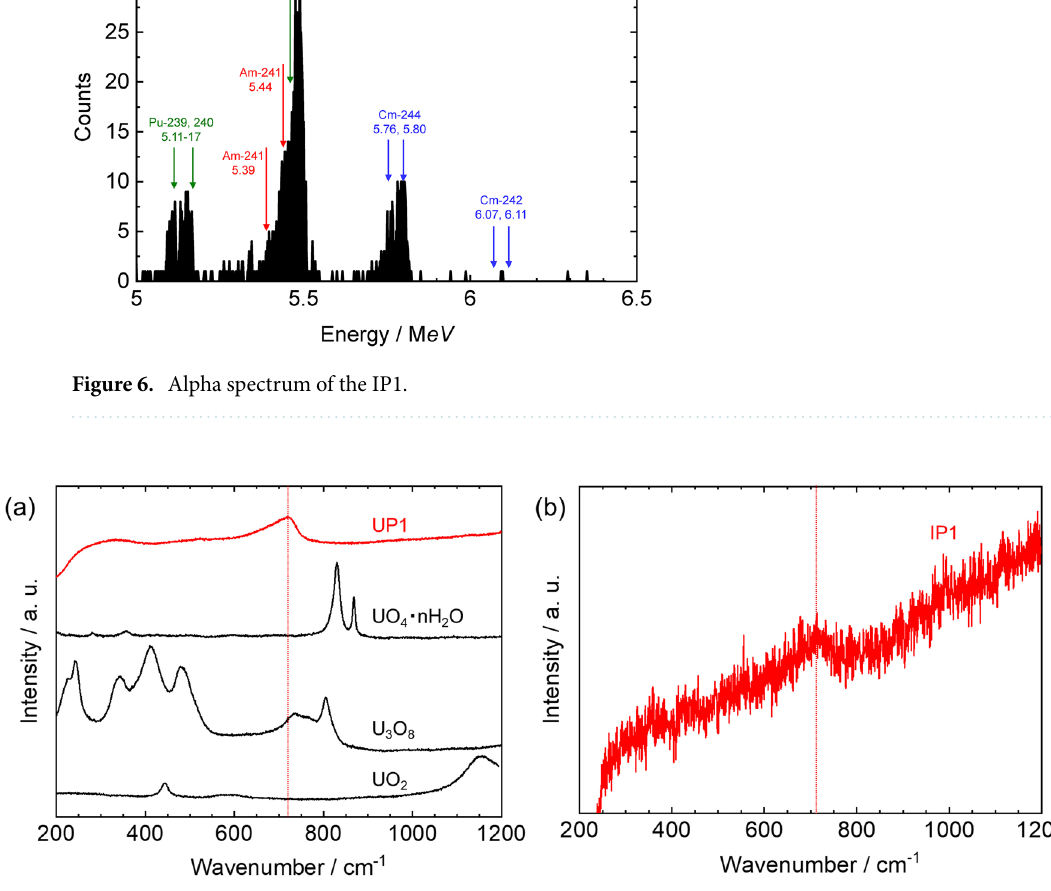
Figure 7. ( a ) Raman spectra of UP1 and uranium standard samples. ( b ) A Raman spectrum of